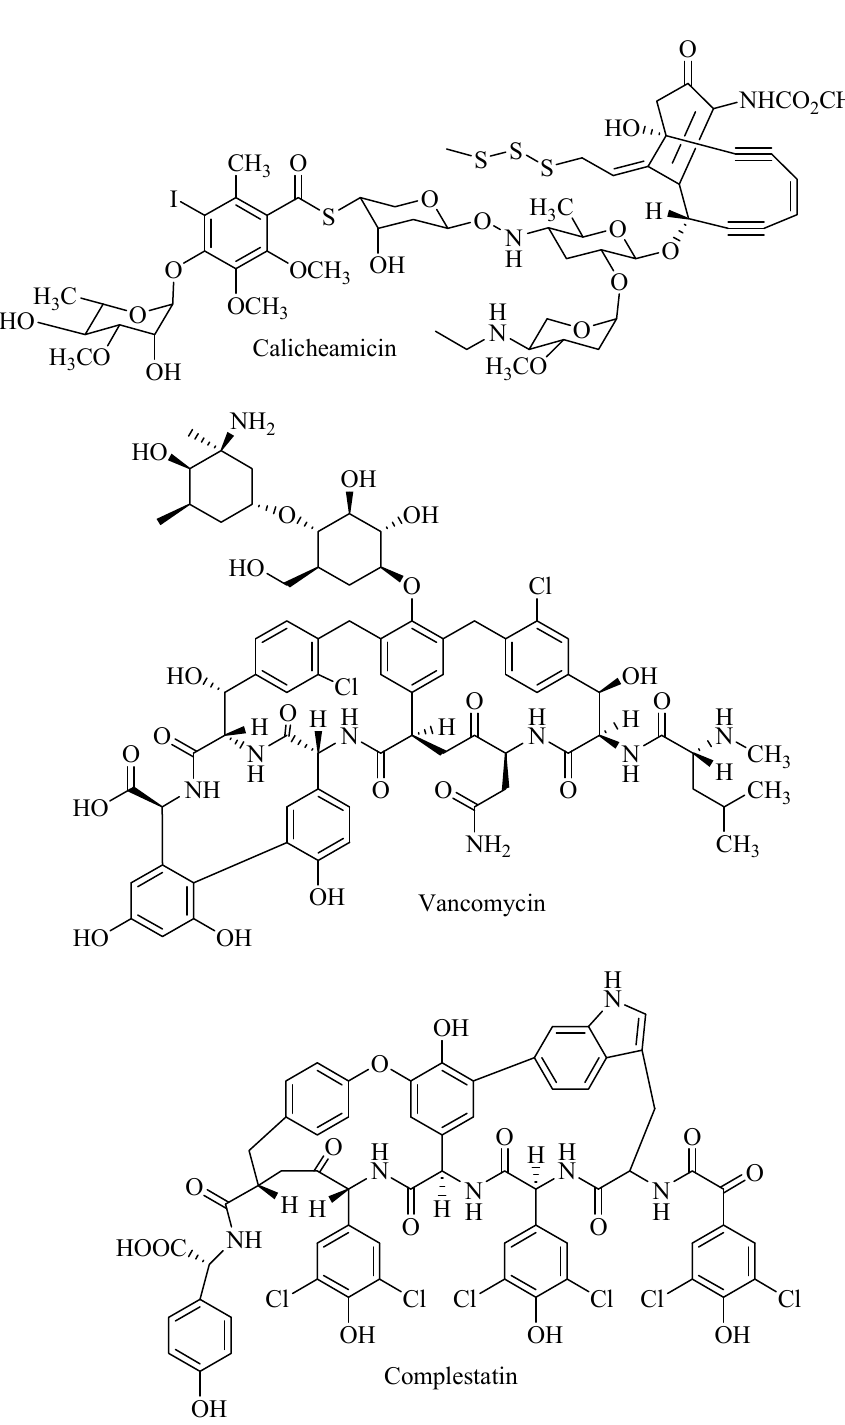
Figure 1. Halometabolites from terrestrial Actinobacteria.